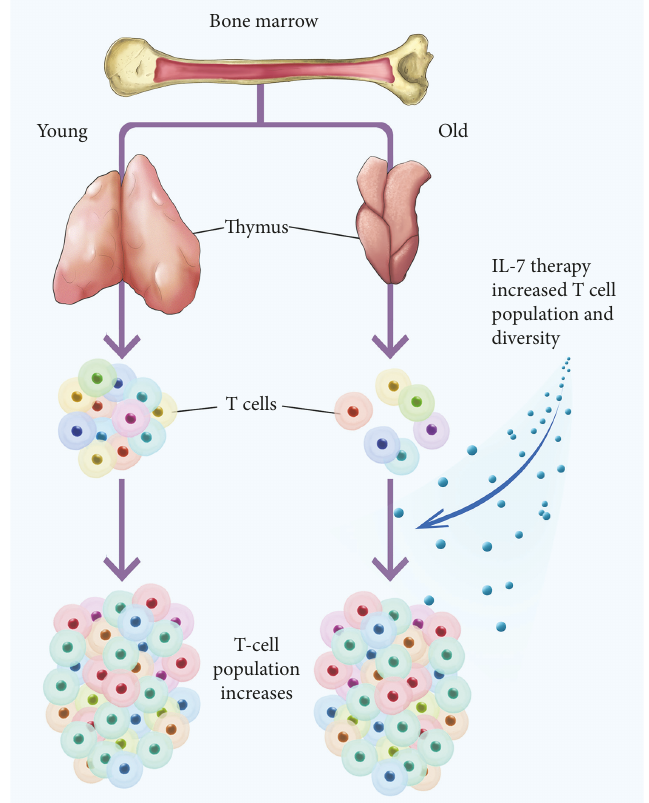
Figure 7: In some studies, Il-7 therapy caused rejuvenation of the T cell population, broadened immune responses in cancer patients, and enhanced T cell recovery in HIV-1-infected adults. (See Section